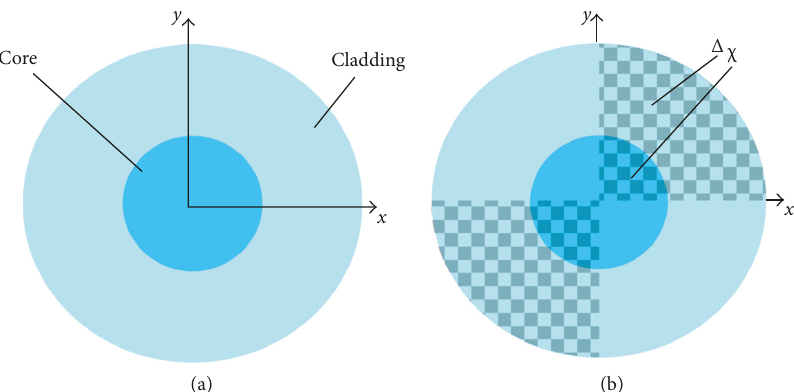
Figure 1: Spatial-dependent linear inhomogeneity and orthogonal propagating modes: (a) Unperturbed fiber; (b) perturbed fiber with azimuthal changes Δ χ ( θ ) of periodicity π / 2.